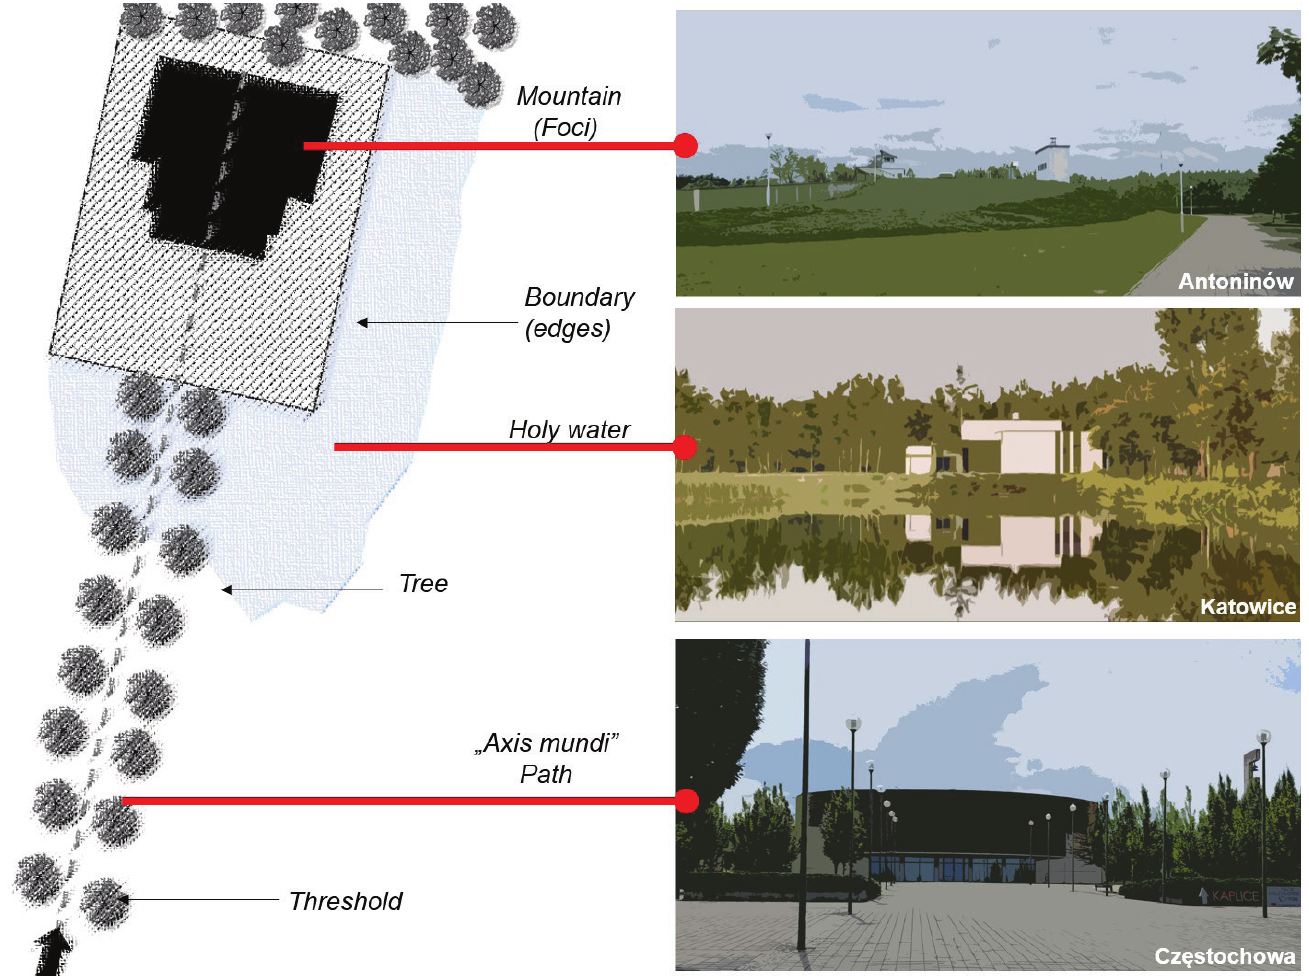
Figure 11. Multifaceted funerary landscape in Poland. Own